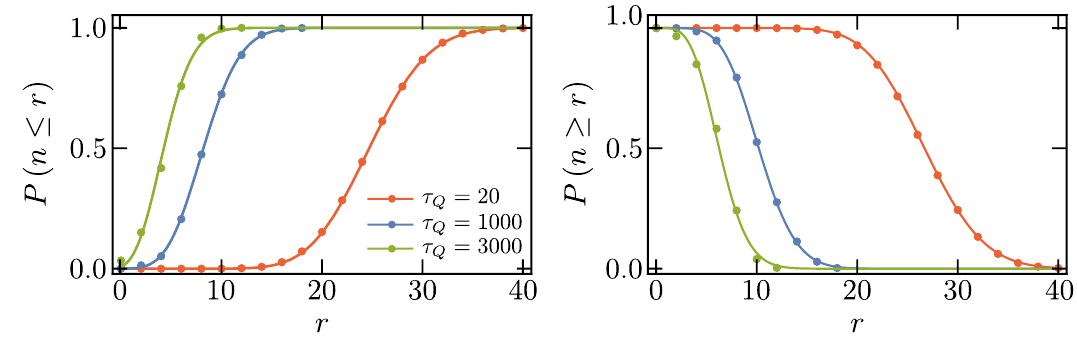
Figure 10 . Cumulative probability P ( n ≤ r ) (Left) and P ( n ≥ r ) (Right) for τ Q = 20 , 1000 and 3000 . Numerical results fit closely the theoretical predictions derived from the EP distribution in eq. (D.1) and eq. (D.2).